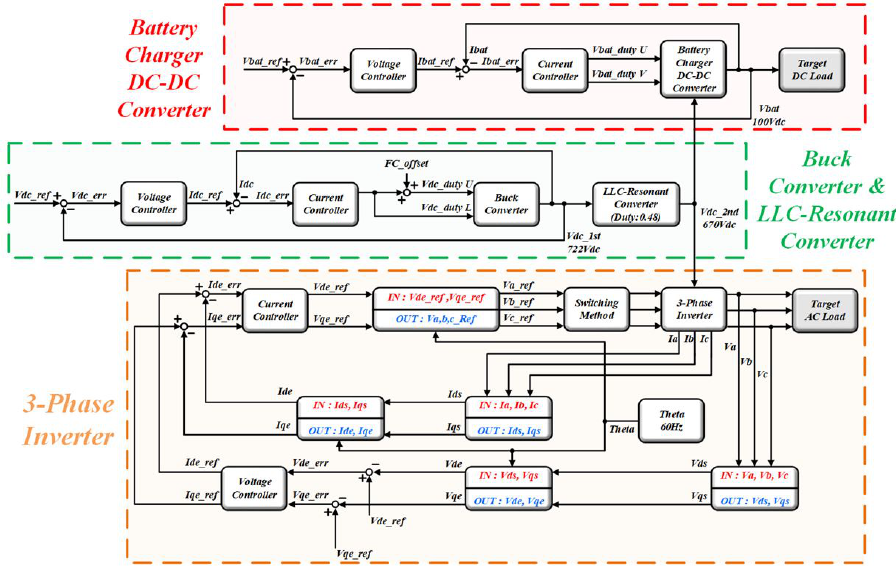
Figure 14. Control block diagram of the overall resonant auxiliary power supply